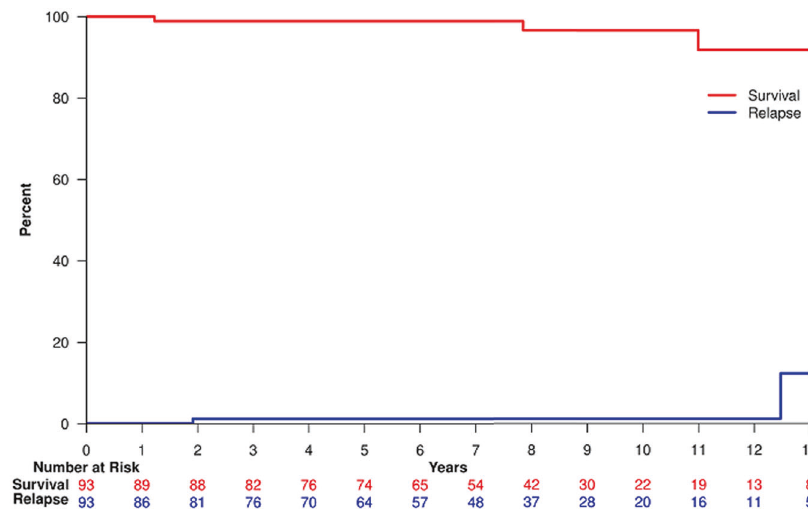
Fig. 1 Survival and cumulative incidence of recurrence. Overall survival (red) and cumulative incidence of recurrence